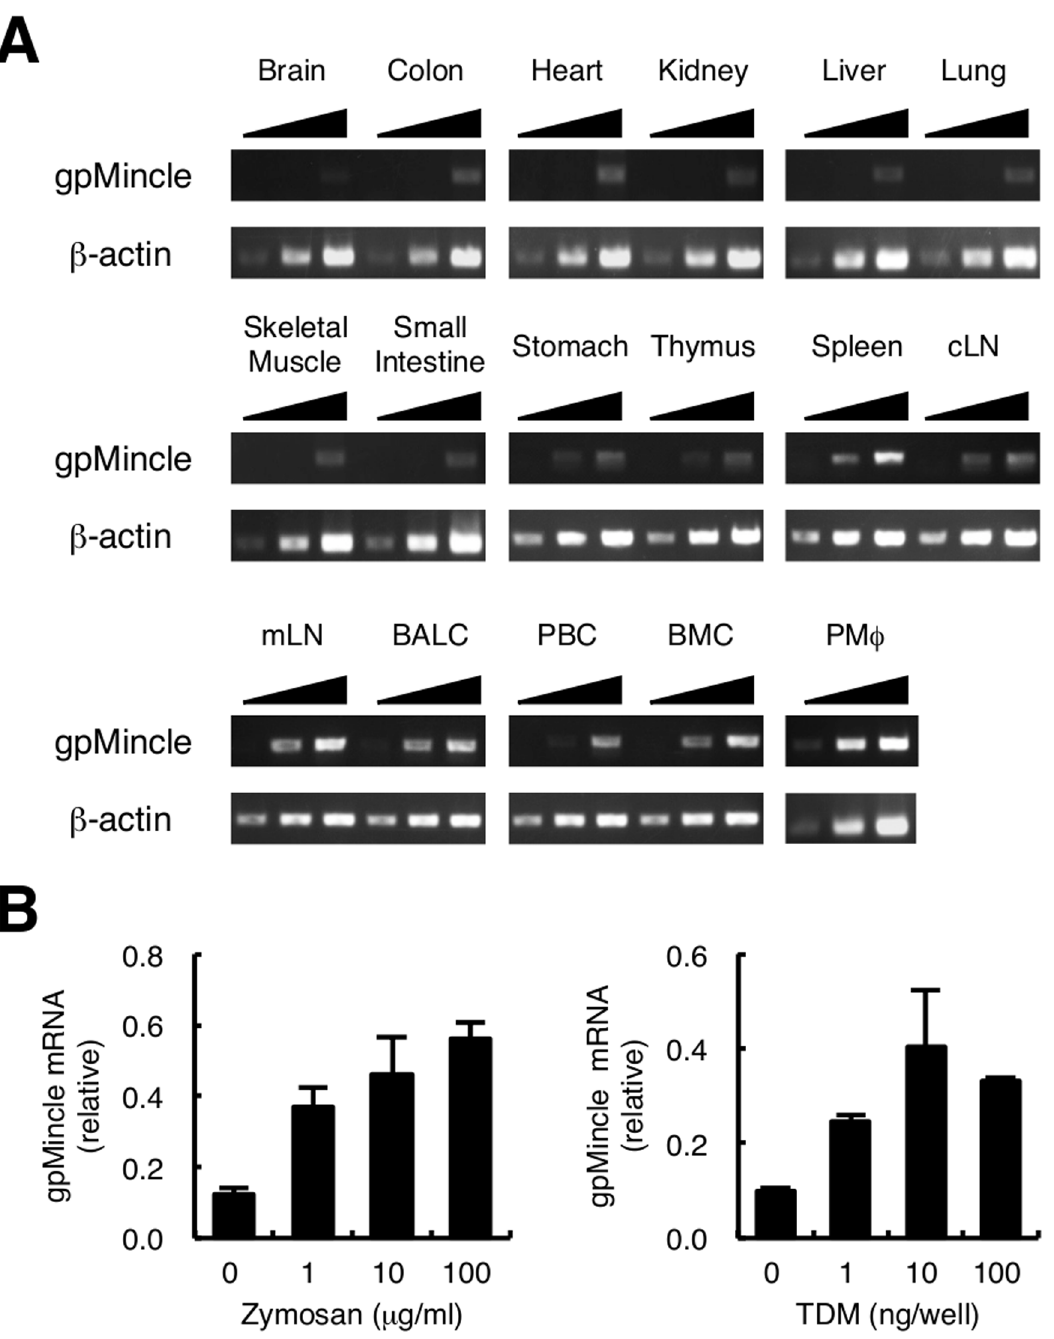
Figure 1. Expression of gpMincle mRNA. (A) Tissue distribution of gpMincle mRNA. mRNA expression of gpMincle in indicated tissues (cLN, cutaneous lymph node; mLN, mesenteric lymph node) and cells (BALC, bronchoalveolar lavage cell; PBC, peripheral blood cell; BMC, bone marrow cell; PMø, thioglycollate-elicited peritoneal macrophage) was detected by PCR. PCR was performed by increased cycle numbers (20, 24, 28 for b -actin and 32, 36, 40 for Mincle). (B) gpMincle mRNA is induced upon stimulation. Macrophages were stimulated with indicated concentrations of zymosan (left panel) or TDM (right panel). mRNA expression of gpMincle was analyzed by RT-PCR at 8 h after stimulation. Data are presented as mean 6 s.d. (B) and representative of two separate experiments.